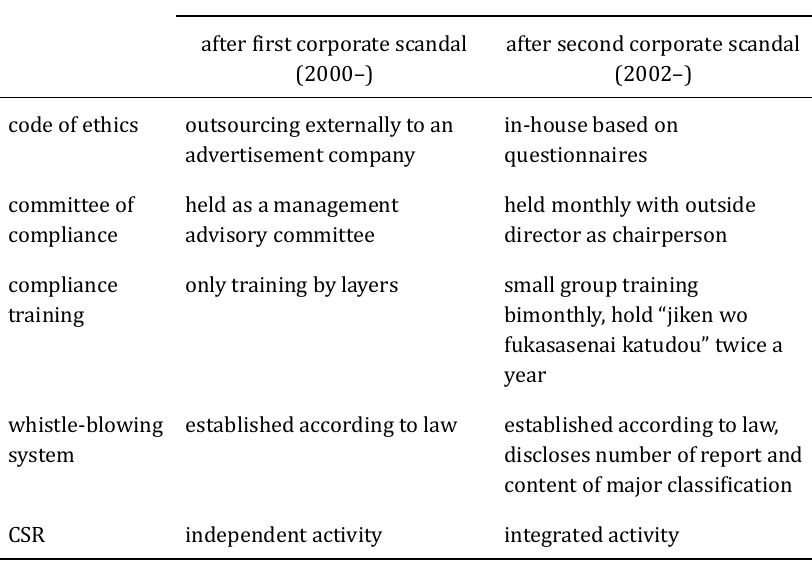
Table 2. Change of X’s compliance